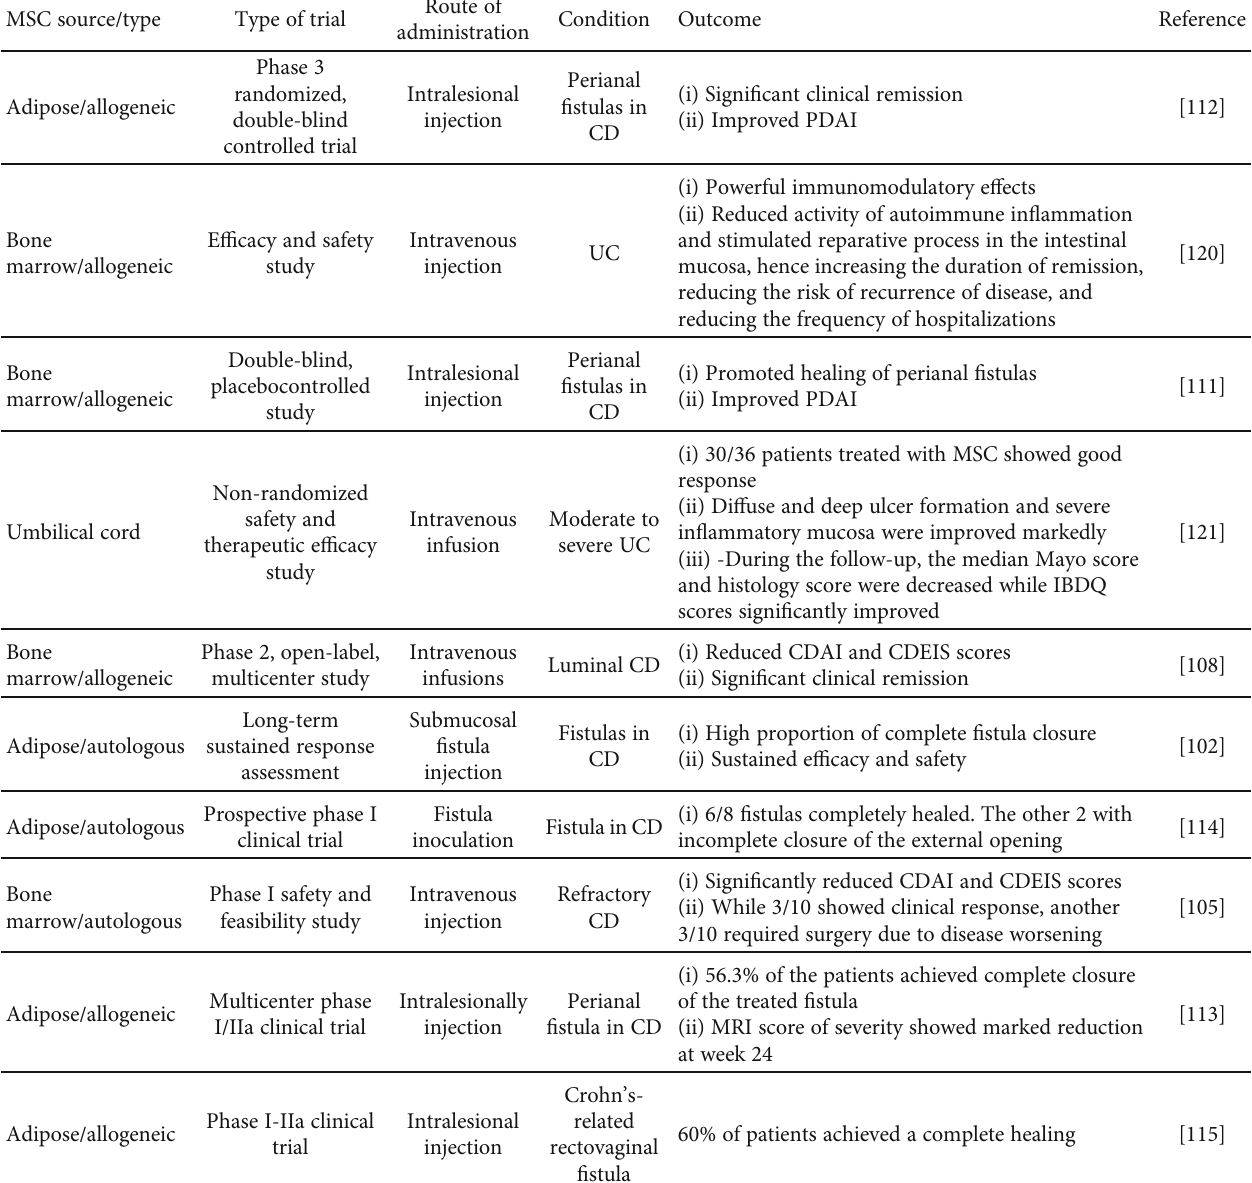
Table 2: Clinical trials of MSC-based therapy in